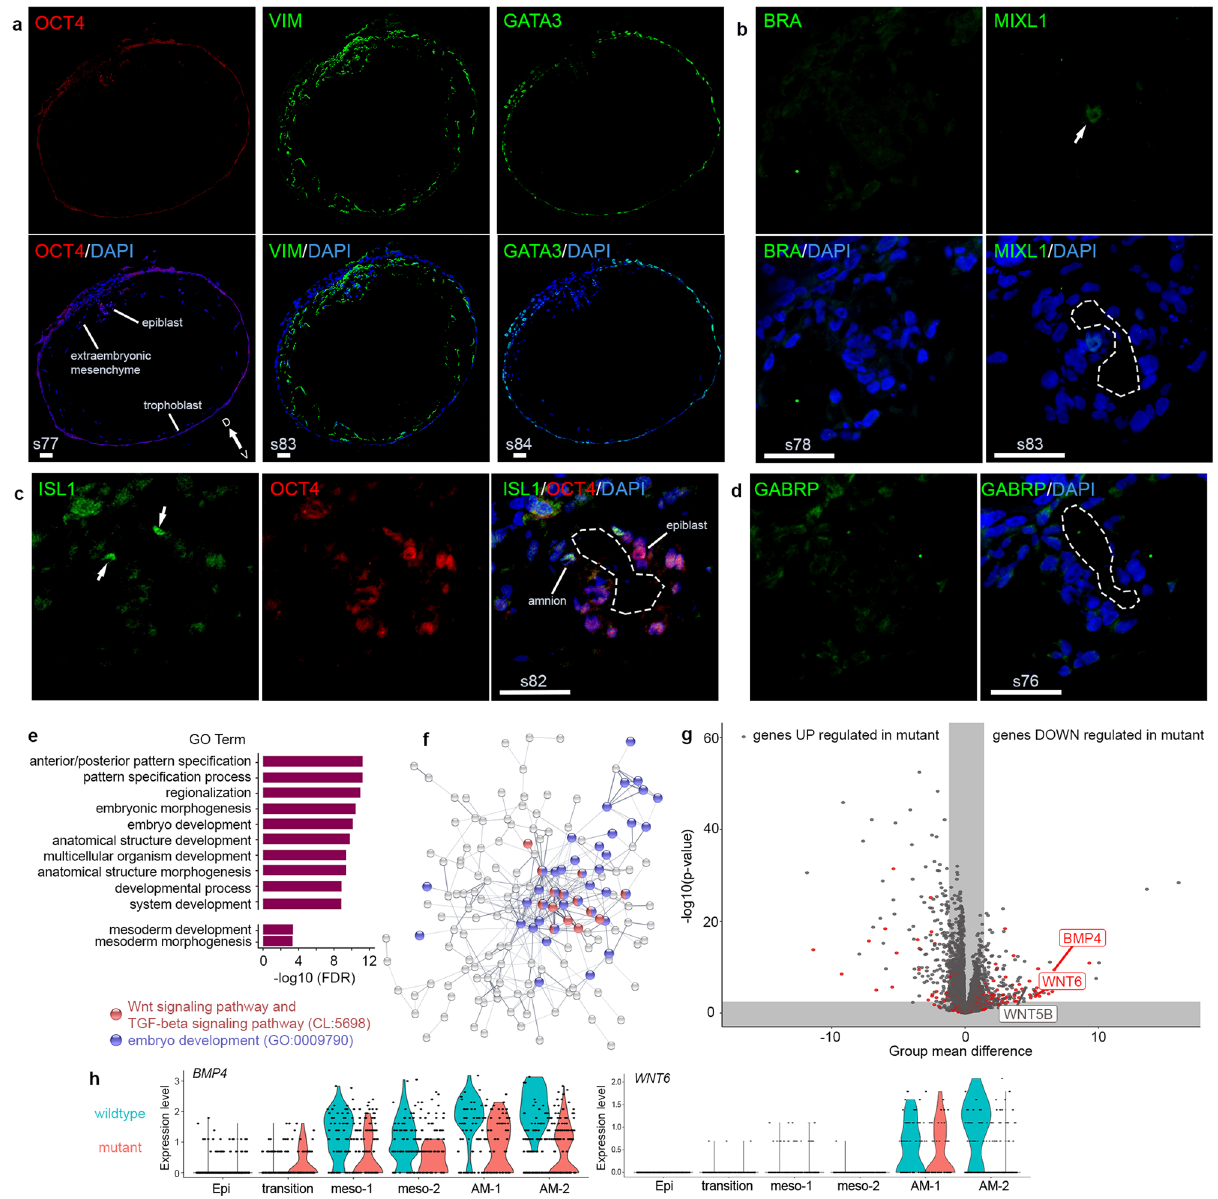
Fig. 4 Loss of ISL1 impairs amnion signals essential for mesoderm formation. See also Supplementary Fig. 8 and Supplementary Data 5. a – d Immuno fl uorescent staining of major cell types on sections of ISL1 mutant embryos at Day 14. n = 3 mutant embryos. a OCT4, VIM, and GATA3; b BRA and MIXL1; c ISL1; d GABRP. Scale bar 50 µ m. Numbers represent section numbers. Arrows indicate signals of interest and dashed lines mark the amniotic cavity. e GO categories enriched among genes signi fi cantly downregulated in cells of the mesodermal clusters in mutant embryos ordered by false discovery rate (FDR). n = 4 wild-type and 4 mutant embryos collected in two batches. f STRING network of all signi fi cantly downregulated genes in cells of the mesodermal clusters in the mutant embryos. Nodes not connected to the main network have been removed. Nodes belonging to the GO category embryonic development colored in blue; nodes belonging to the STRING network cluster Wnt signaling pathway, and TGF-beta signaling pathway colored in red. g Volcano plot showing the DEGs between amnion (AM-1 and AM-2) of the wild-type and mutant embryos. Gray areas indicate the expected group mean difference in random cell subsets (99.9th percentile) and a false discovery rate cutoff of 1%. Red labeling indicates that the gene is part of the ISL1 regulon identi fi ed by SCENIC. P values were calculated using a two-tailed Welch ’ s t test. The x -axis reports uncorrected p values. h Violin plot of the expression levels of BMP4 and WNT6 in the different cell types identi fi ed in (Fig. 1d) at Day 14 separated between wild-type (blue) and mutant (red) embryos. Epi epiblast, AM-1 amnion 1, AM-2 amnion 2, meso-1 mesoderm 1, meso-2 mesoderm 2, wt wild type, mt mutant, D dorsal, V